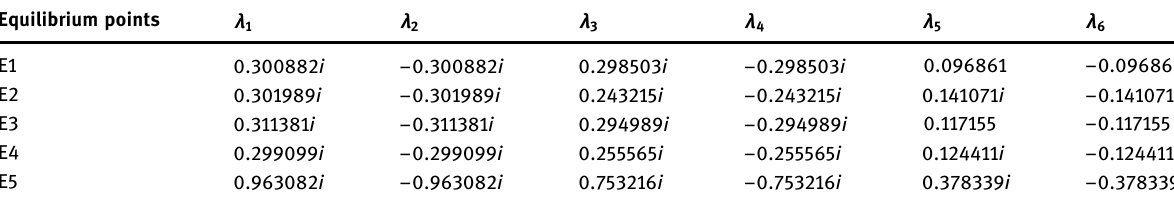
Table 2: Eigenvalues of the equilibrium points around Minerva Equilibrium points